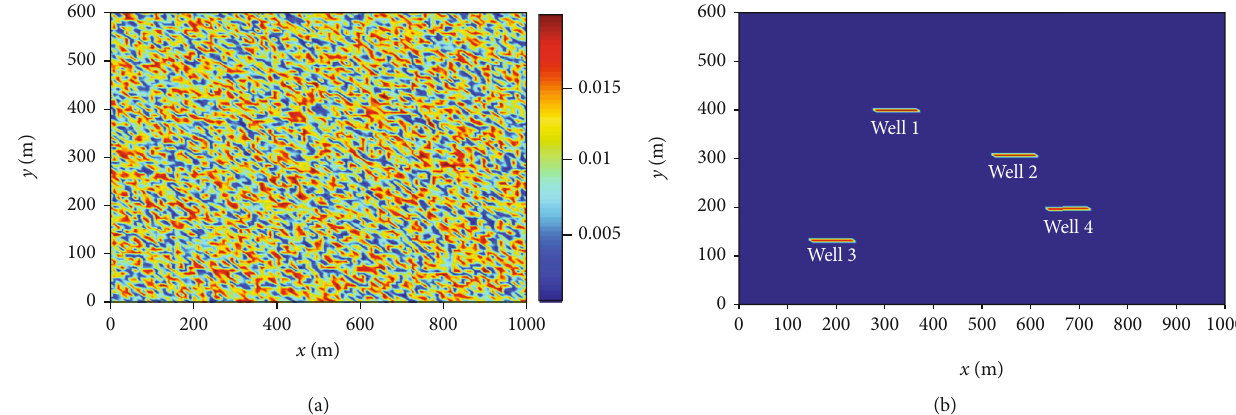
Figure 7: Reservoir model #2 that is used for the validation purpose: (a) distribution of the matrix permeability and (b) distribution of the fractured